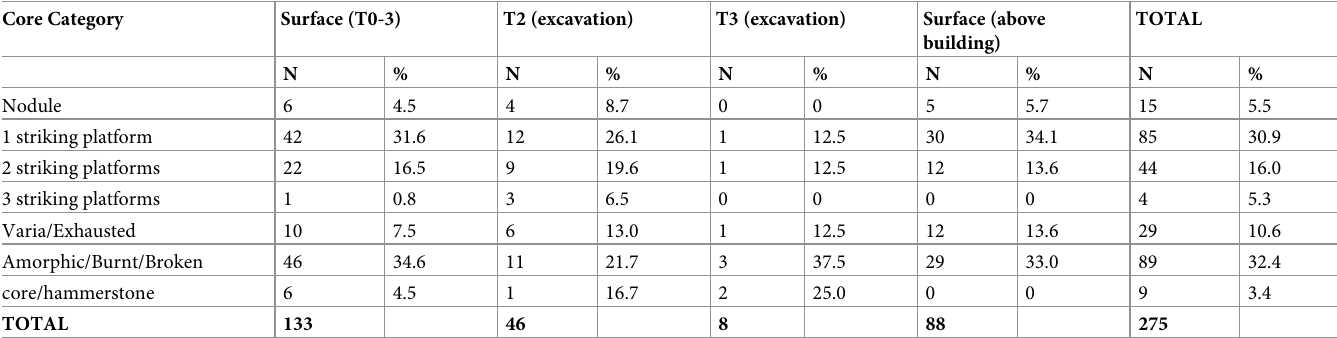
Table 6. Core categories–Kaizer Hill